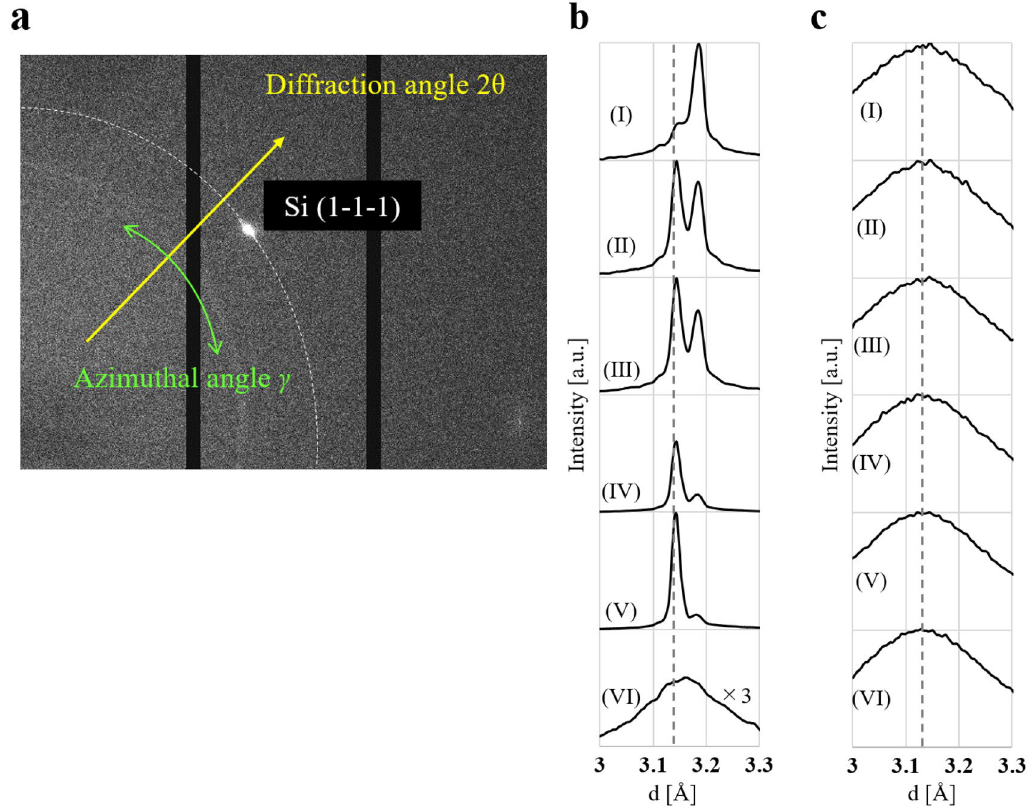
Figure 5. Two-dimensional XRD pattern and the lattice spacing. ( a ) Two-dimensional XRD pattern of the LIPSS formed by Ti:Sapphire laser. ( b , c ) The lattice spacing-intensity profiles of the LIPSS formed by Ti: sapphire laser and MIR-FEL. The lattice spacing-intensity profiles show the depth dependence. The center position of the x-ray beam was at (I) 20 μm above from the top surface of the LIPSS, (II) 10 μm above from the top surface of the LIPSS, (III) the top surface of the LIPSS, (IV) 10 μm below the top surface of the LIPSS, (V) 20 μm below, (VI) 200 μm below the top surface of the